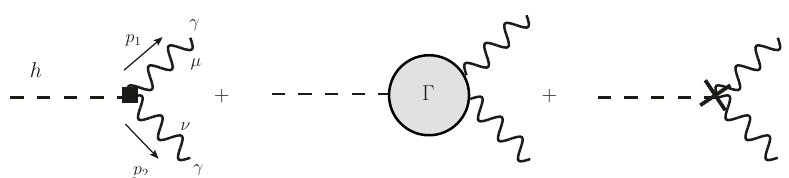
Figure 1 . The sum of three types of diagrams: (left) the SMEFT \tree" contribution with momenta and space-time indices indicated, (center) the 1PI vertex corrections (cid:0) from all operators, SM or not, and (right) the vertex counterterms containing (cid:14)C and (cid:14)v . These corrections should be self- explained in eq. (3.13).